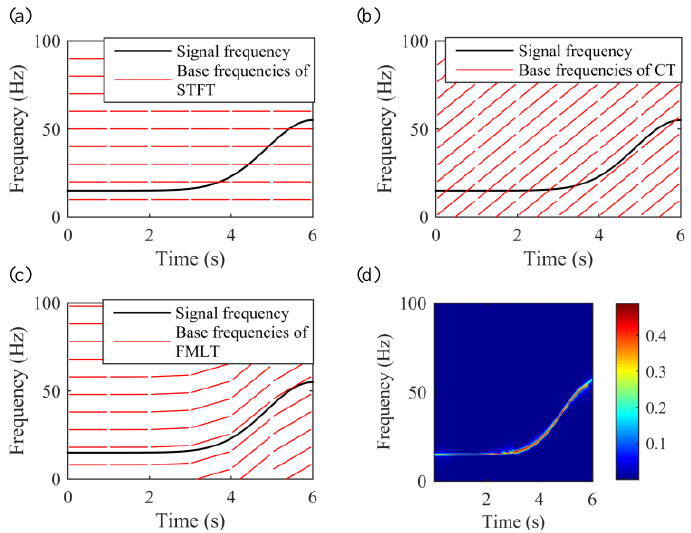
Figure 3. Base frequencies of different linear transform (LT) methods: ( a ) base frequencies of STFT, ( b ) base frequencies of CT, ( c ) bases frequencies of the proposed frequency matching linear transform (FMLT), and ( d ) FMLT-resulting TFR.